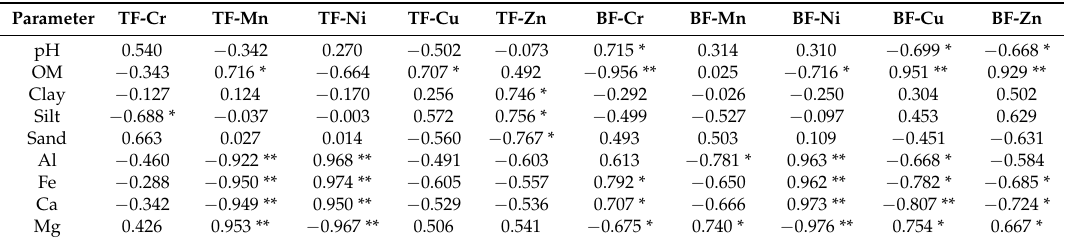
Table 4. Correlation coefficients between bioaccumulation or translocation factors of heavy metal and physicochemical properties of tailing